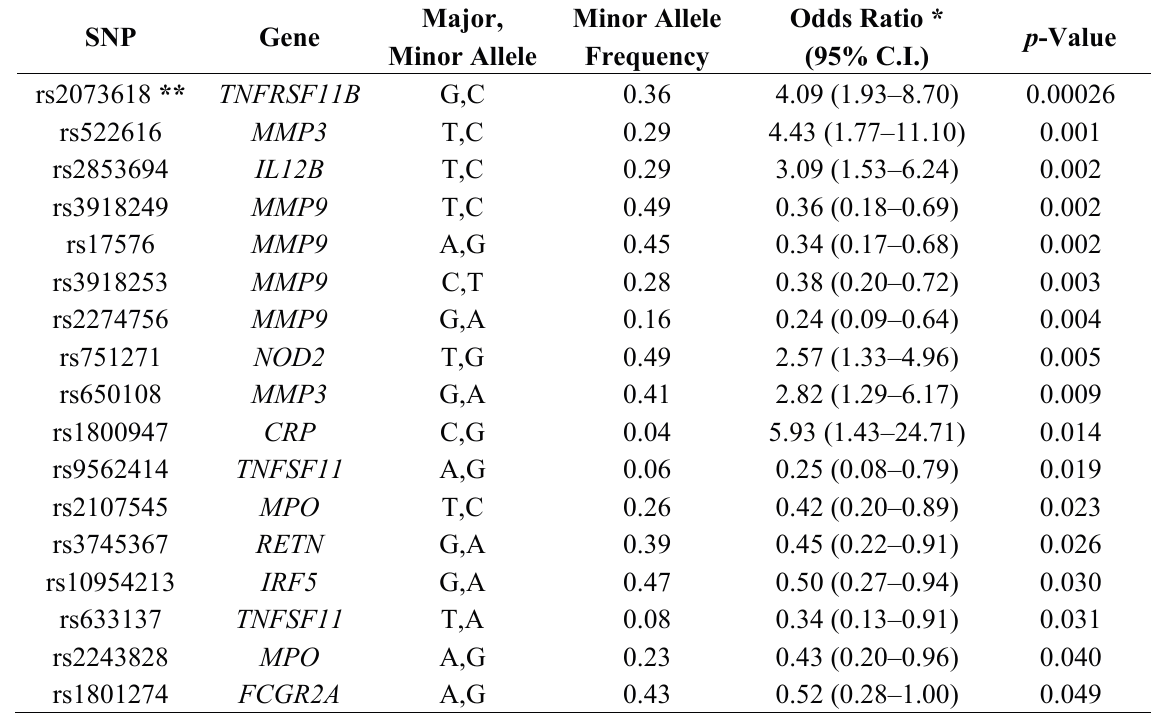
Table 2. Genetic association with coronary atherosclerosis in patients with rheumatoid arthritis (RA). SNP Gene